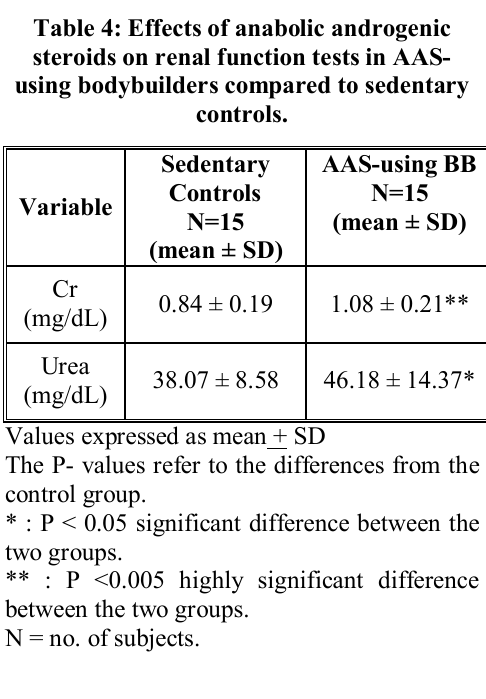
Table 4: Effects of anabolic